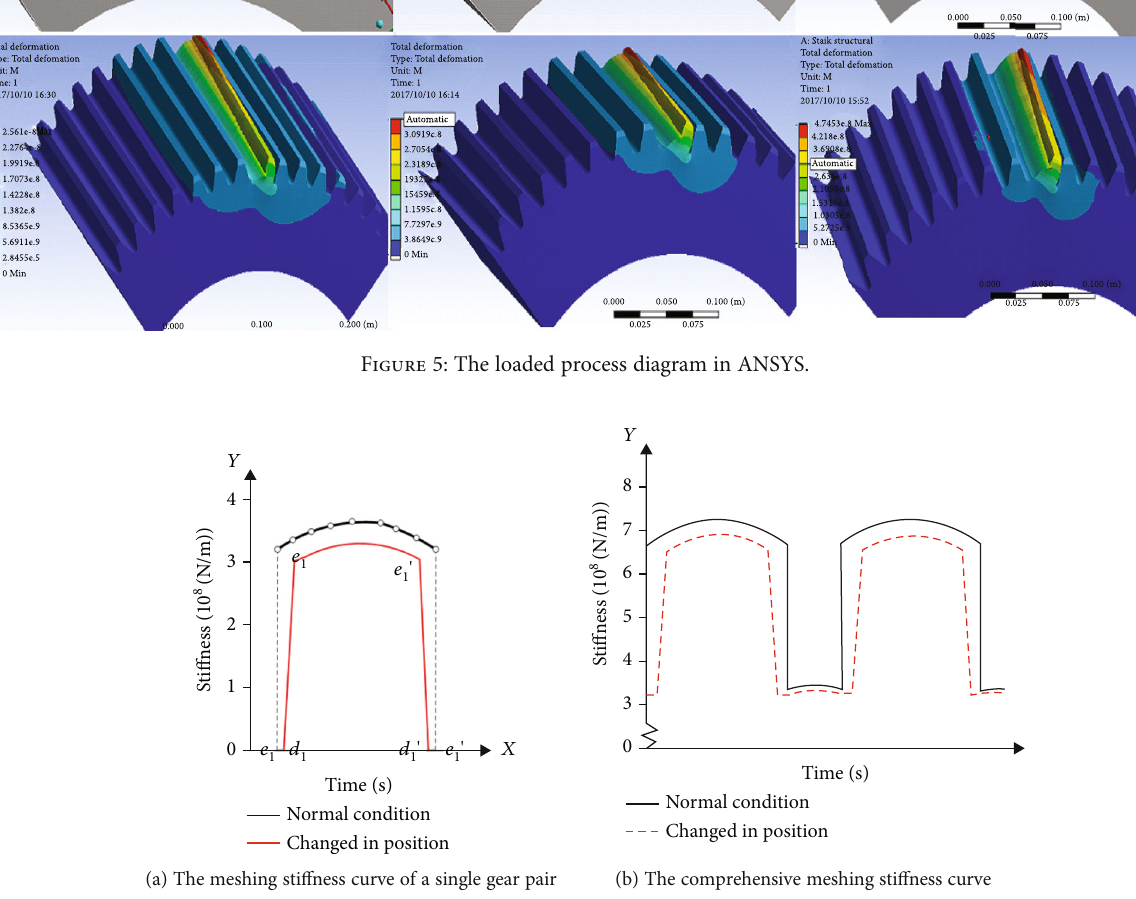
Figure 6: The time-varying meshing sti ff ness